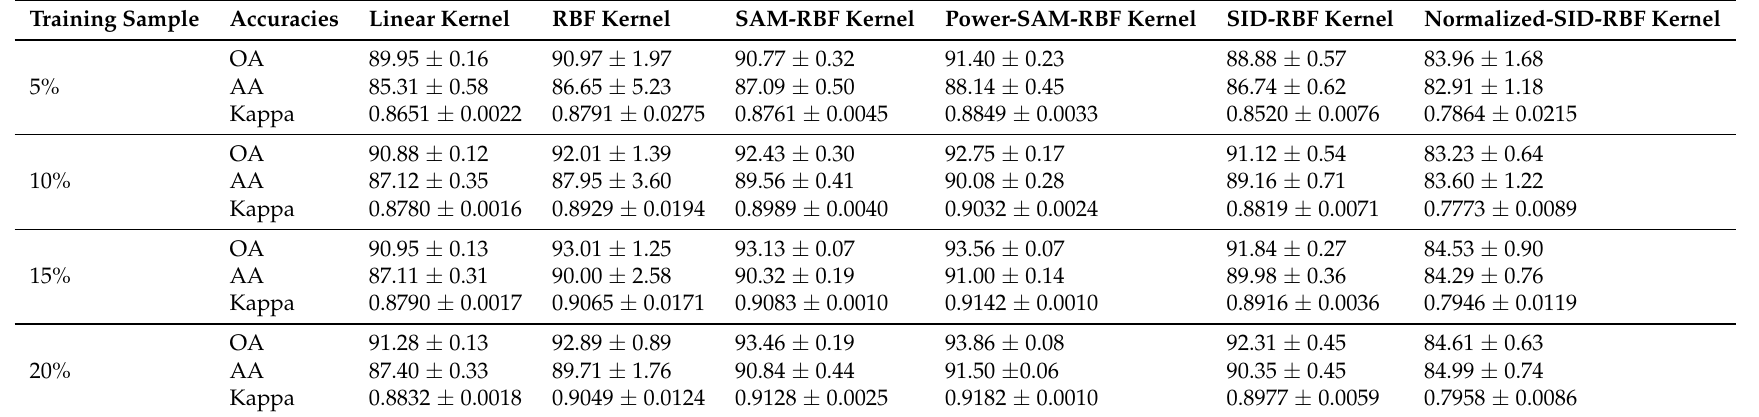
Table 4. OAs, AAs, kappa coefficients of the Linear, RBF, SAM-RBF, Power-SAM-RBF, SID-RBF, and Normalized-SID-RBF kernels on the University of Pavia